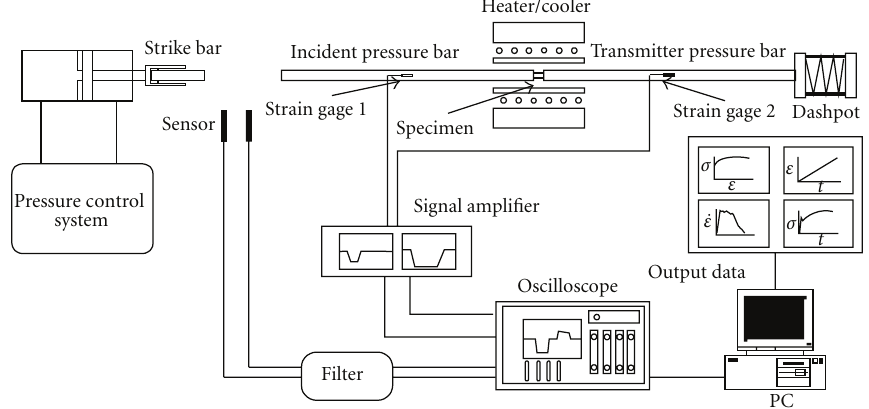
Figure 1: Schematic diagram of compressive split Hopkinson pressure bar system.